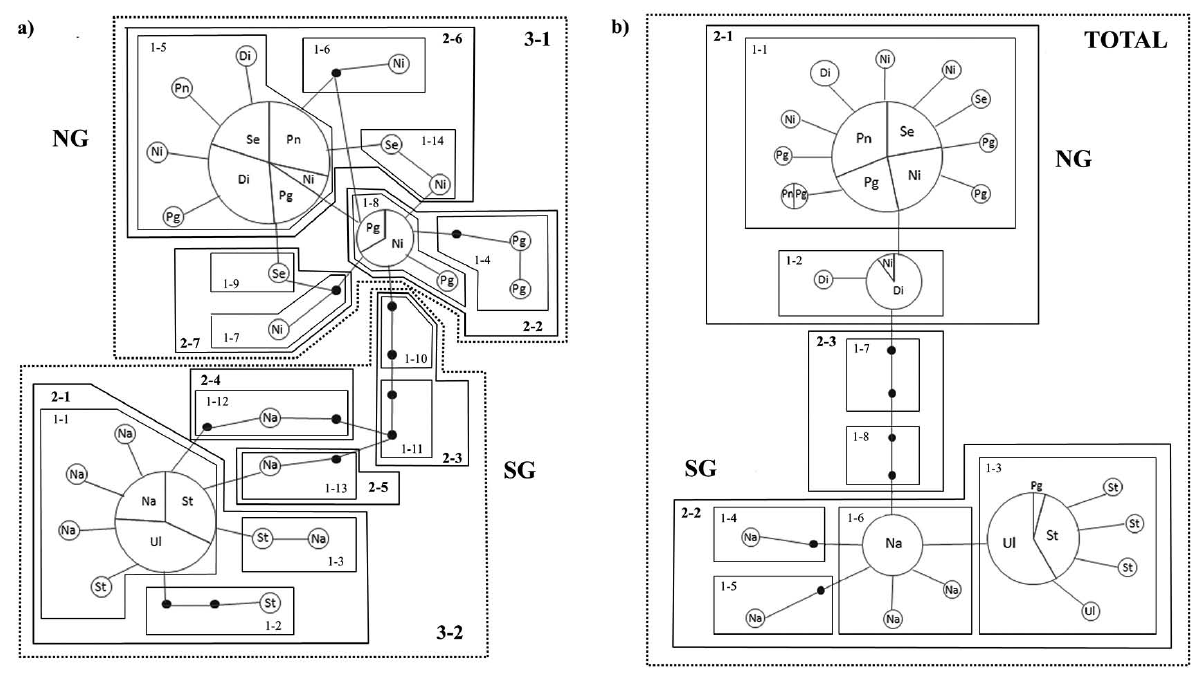
Fig. 2. – Statistical parsimony networks of the eastern Adriatic Aphanius populations based on mtDNA CR sequences (a) and nested clade de- sign for the network containing cyt b haplotypes (b). Each line in the network represents a single mutational change; circle size of haplotypes is proportional to their number; small black circles represent unobserved haplotypes. Se-Se č ovlje, Pg-Pag, Ni-Nin, Di-Dinjiška, Pn-Pantan, St-Ston, Ul-Ulcinj, Na-Narta. NG and SG explain populations belonging to Northern and Southern group, respectively.